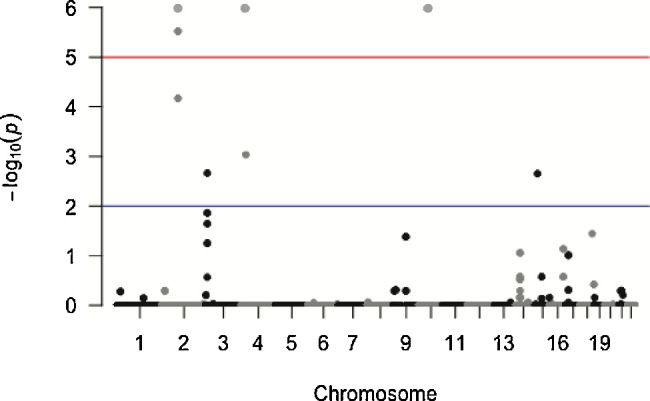
Segmental tests show three significant duplications. Manhattan plot of segmental association test results representing genome-wide corrected p values calculated at each CNV breakpoint. Black circles represent deletions, and gray circles represent duplications. Three duplications, on chromosomes 2, 4, and 10, were significant to P = 1 × 10−6. The three circles for chromosome 2 represent the same duplication, which has different breakpoints in different individuals. Some of the individual breakpoints have lower P values.